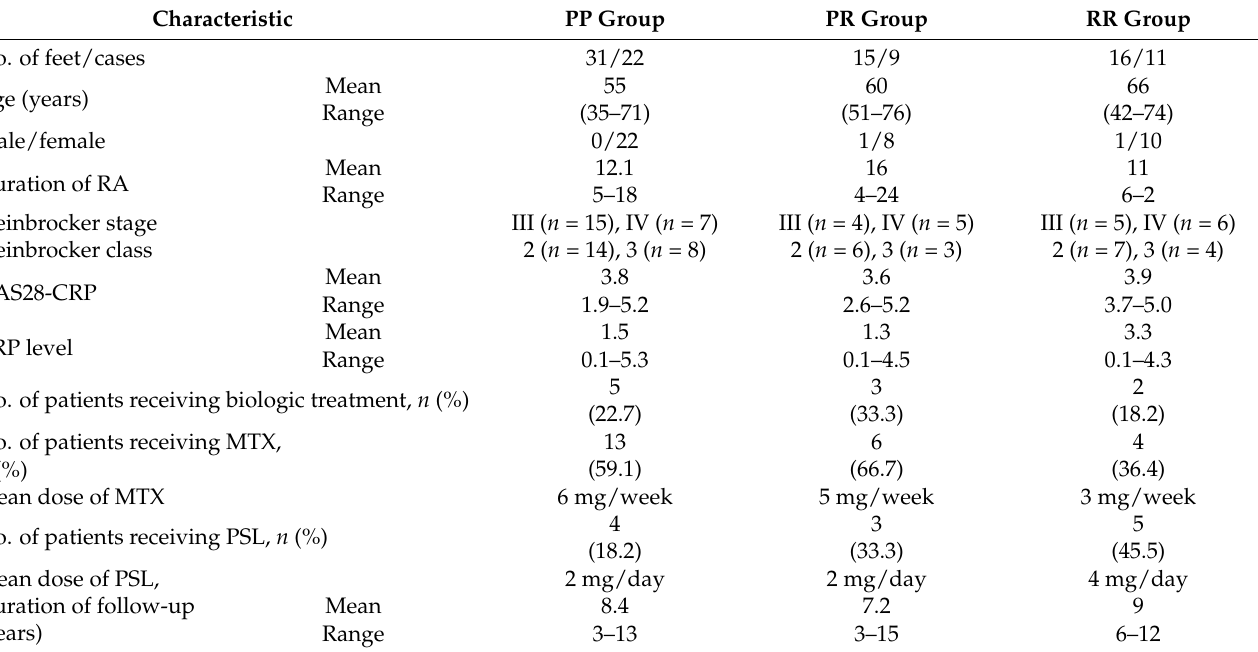
Table 1. Characteristics of patients with